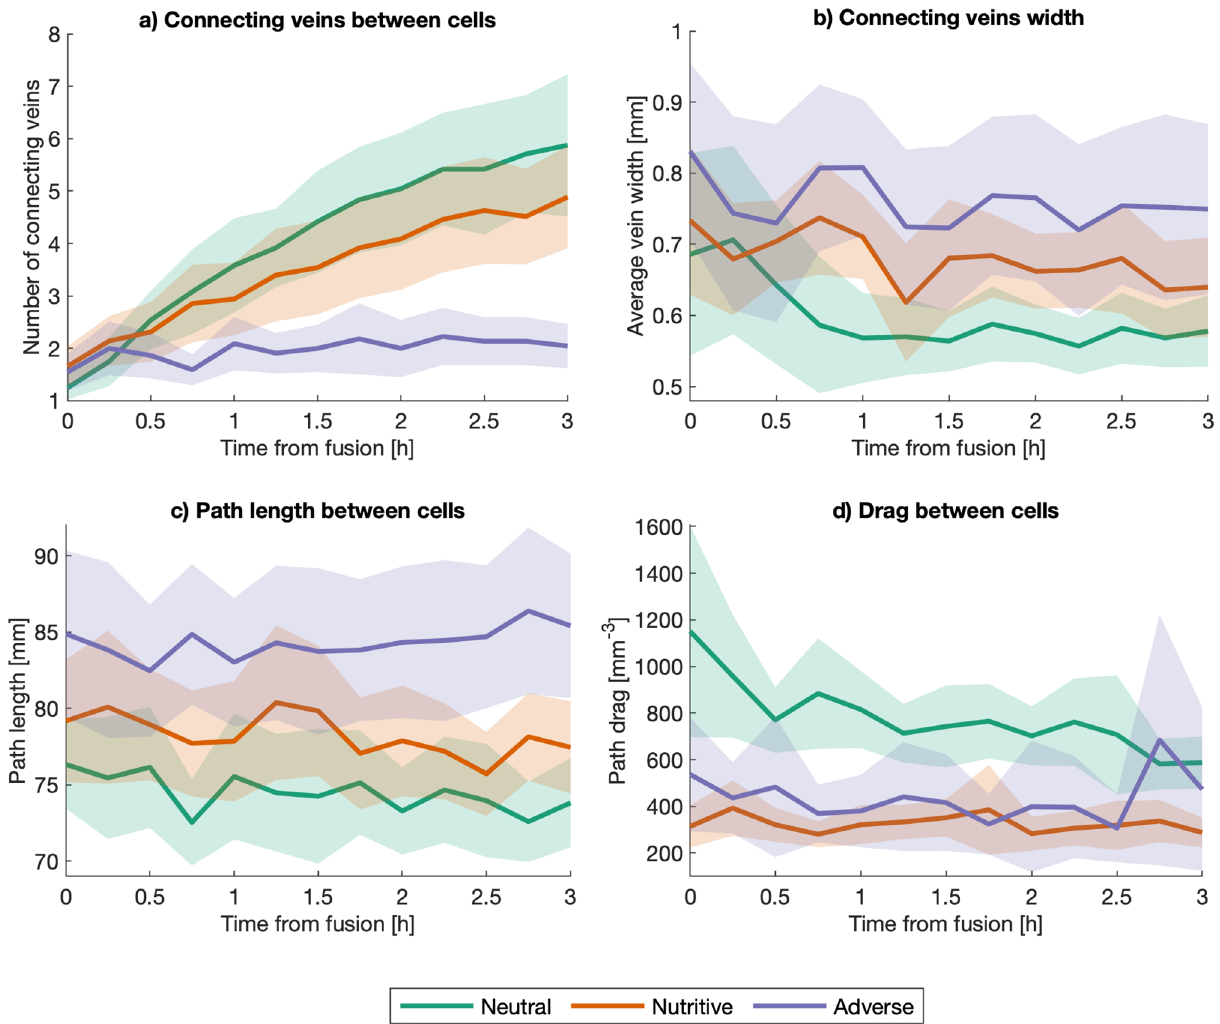
Figure 19. Connectivity between slime mold cells. ( a ) Number of connecting veins between fused slime mold cells. ( b ) Average width of the connecting veins, calculated as the total width of the region between slime mold cells, divided by the number of connecting veins. ( c ) Path length between initial slime mold cells: shortest distance between the two initial slime mold cells along the network. ( d ) Minimum drag along the path connecting the two initial slime mold cells in the